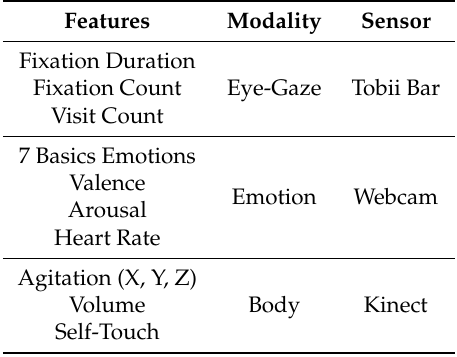
Table 1. Features of